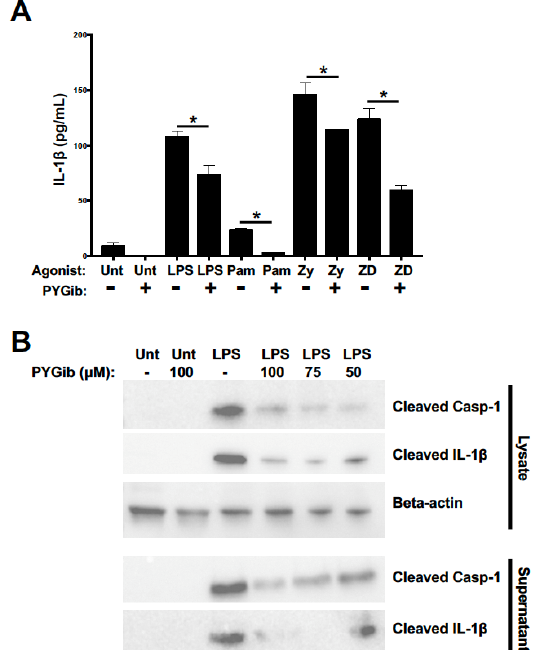
Figure 4. Glycogen phosphorylase inhibition causes deficits in IL-1 β secretion and NLRP3 inflammasome priming in response to TLR and Syk-dependent CLR agonists: ( A ) DCs were stimulated for 6 h with the indicated conditions above and supernatants were then collected and analyzed for total IL-1 β secretion by ELISA. For all graphs, statistical values are represented with an asterisk (*) as significant when p values are equal to or below 0.05, with mean +/ − SD shown, n = 4. ( B ) DCs were stimulated for 5 h with the conditions indicated above with the last hour containing NLRP3 inflammasome activator nigericin. Cell lysates and supernatants were collected and analyzed for cleaved caspase-1 and cleaved IL-1 β expression. Blots are representative of 3 independent